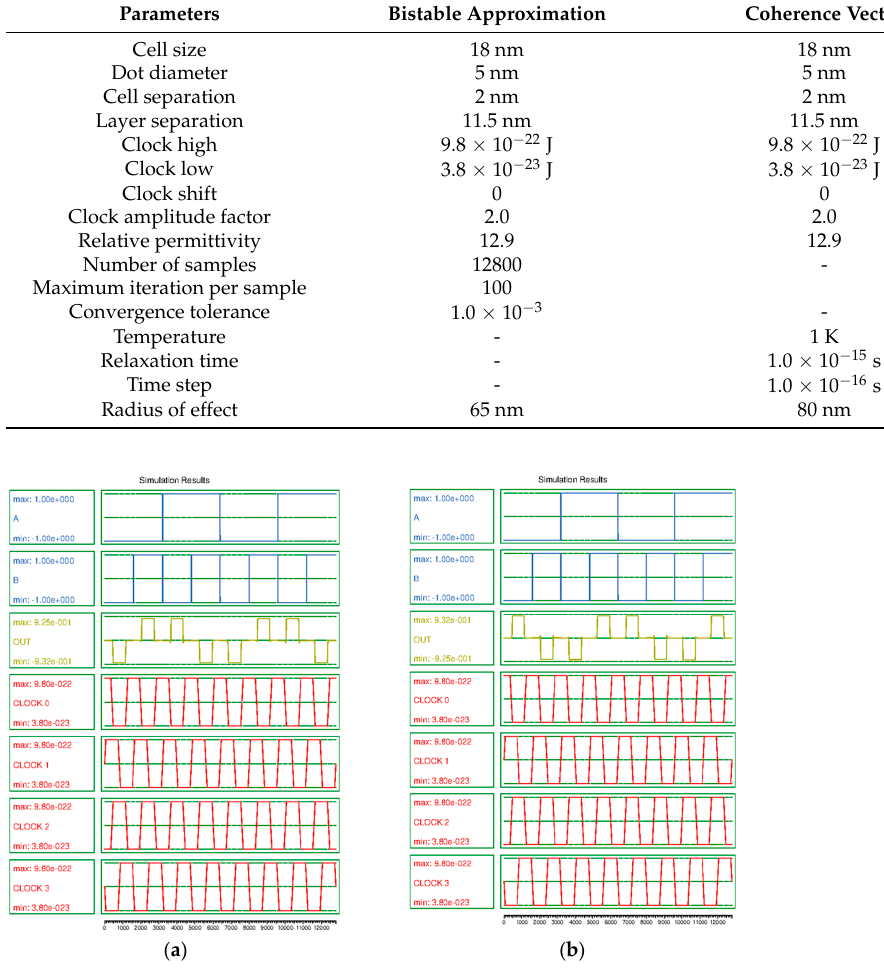
Figure 14. Simulation result: ( a ) XOR gate, ( b ) XNOR gate.